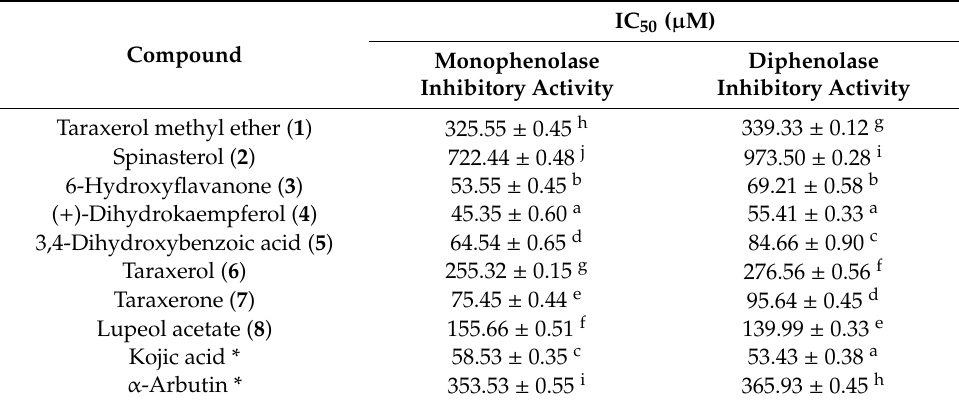
Table 2. Tyrosinase inhibitory activities of compounds 1 - 8